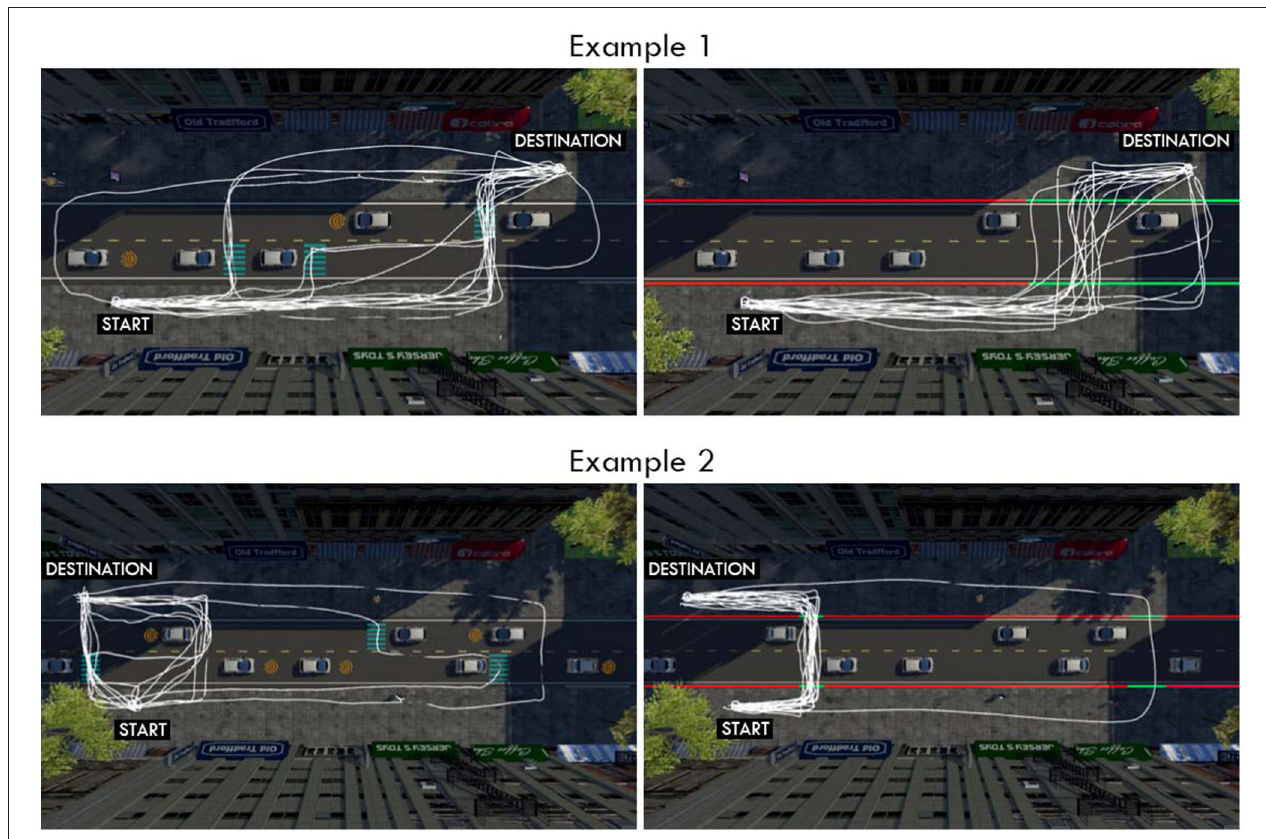
FIGURE 8 | Two examples from the drawing task in two different scenarios (top and bottom). In the figures, the drawing routes from all participants are overlaid, which allowed us to quickly assess the consistency of the suggested walking routes. Here are two example scenarios from the drawing task. The images originate from VR screenshots. Each exemplary scenario shows a starting point and a pre-defined destination. These scenarios differ from the ones which participants experienced in VR. Here, we created more complex situations with five vehicles on the road simultaneously. Cars from the projection condition either show a cyan zebra crossing or an orange wave pattern. Smart Curbs illuminate the curbs either red or green symmetrically on either side of the road. Participants were asked to draw their most likely chosen walking route. We overlaid all drawn paths, and it was clearly observable that for Smart Curbs the path became more consistent and shorter.